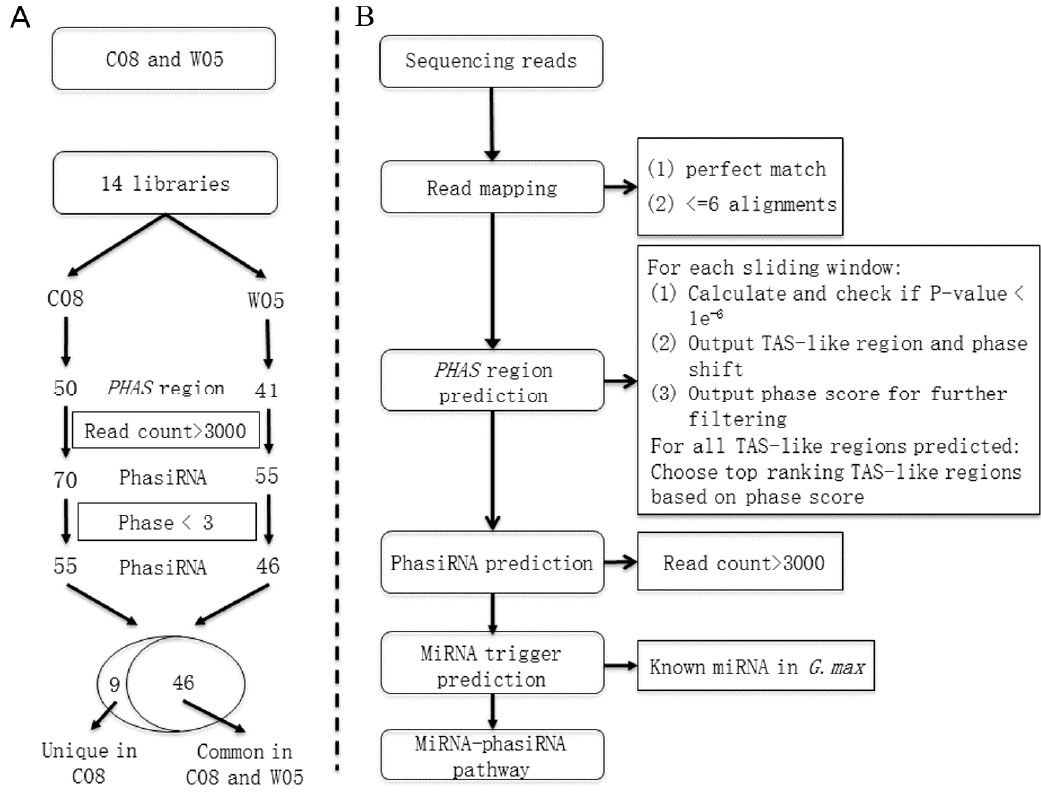
Figure 4. The pipeline for phasiRNA predictions: ( A ) The workflow for the comparisons between the phasiRNA profiles of C08 and W05. The numbers of common and unique phasiRNAs are shown in the Venn diagram; ( B ) The workflow for phasiRNA identification. Sequencing reads were mapped to the reference genome Gmax_275_Wm82.a2.v1 and only those reads that could be mapped to at most six positions on the reference genome with perfect matches were used. A sliding-window method was then applied to predict genome-wide PHAS regions using the pattern of mapped reads based on the ranking of p -values and phase scores. In each predicted PHAS region, loci with on-phase high-count reads (generating phasiRNAs >3000 total reads in seven sample of each variety) were selected and regarded as putative phasiRNA-generating loci. A characterization of each putative phasiRNA was performed to identify any possible miRNA triggers that initiated the biogenesis of phasiRNAs. The final product was a proposed pathway for each miRNA–phasiRNA pair.